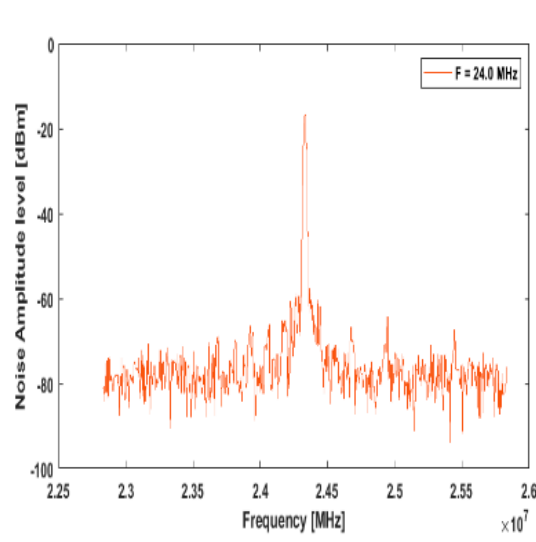
Figure 16. Waveform at 24 MHz.